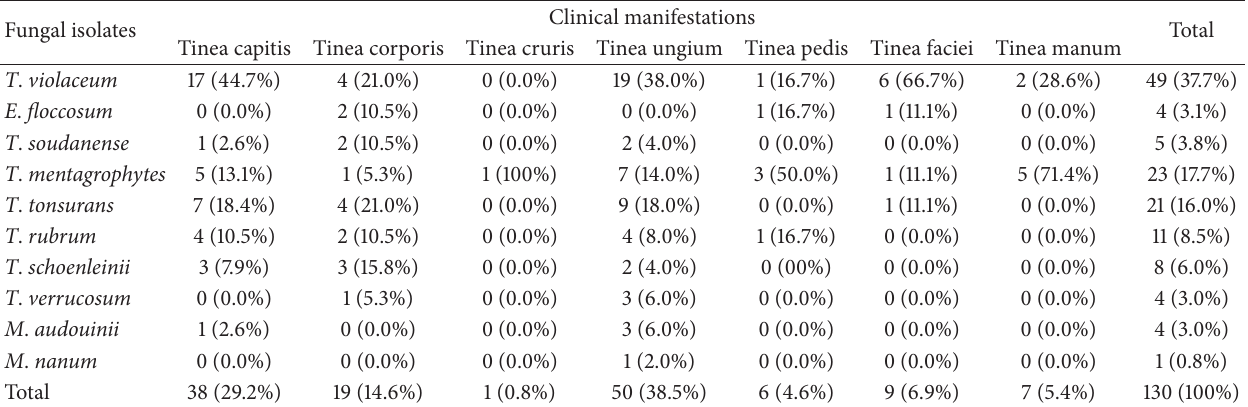
Table 3: Prevalence pattern of dermatophytes across clinical manifestations ( 𝑛 =